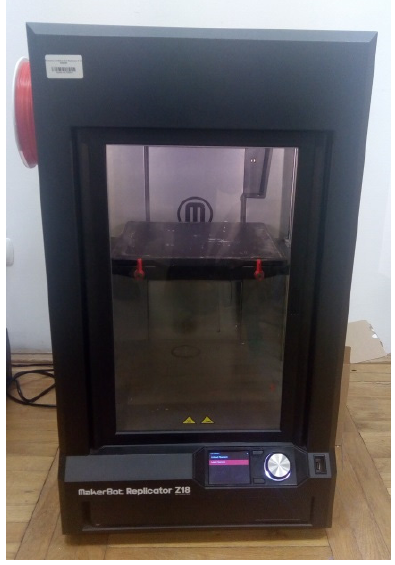
Figure 5. View of the MakerBot Replicator Z18 3D printer.